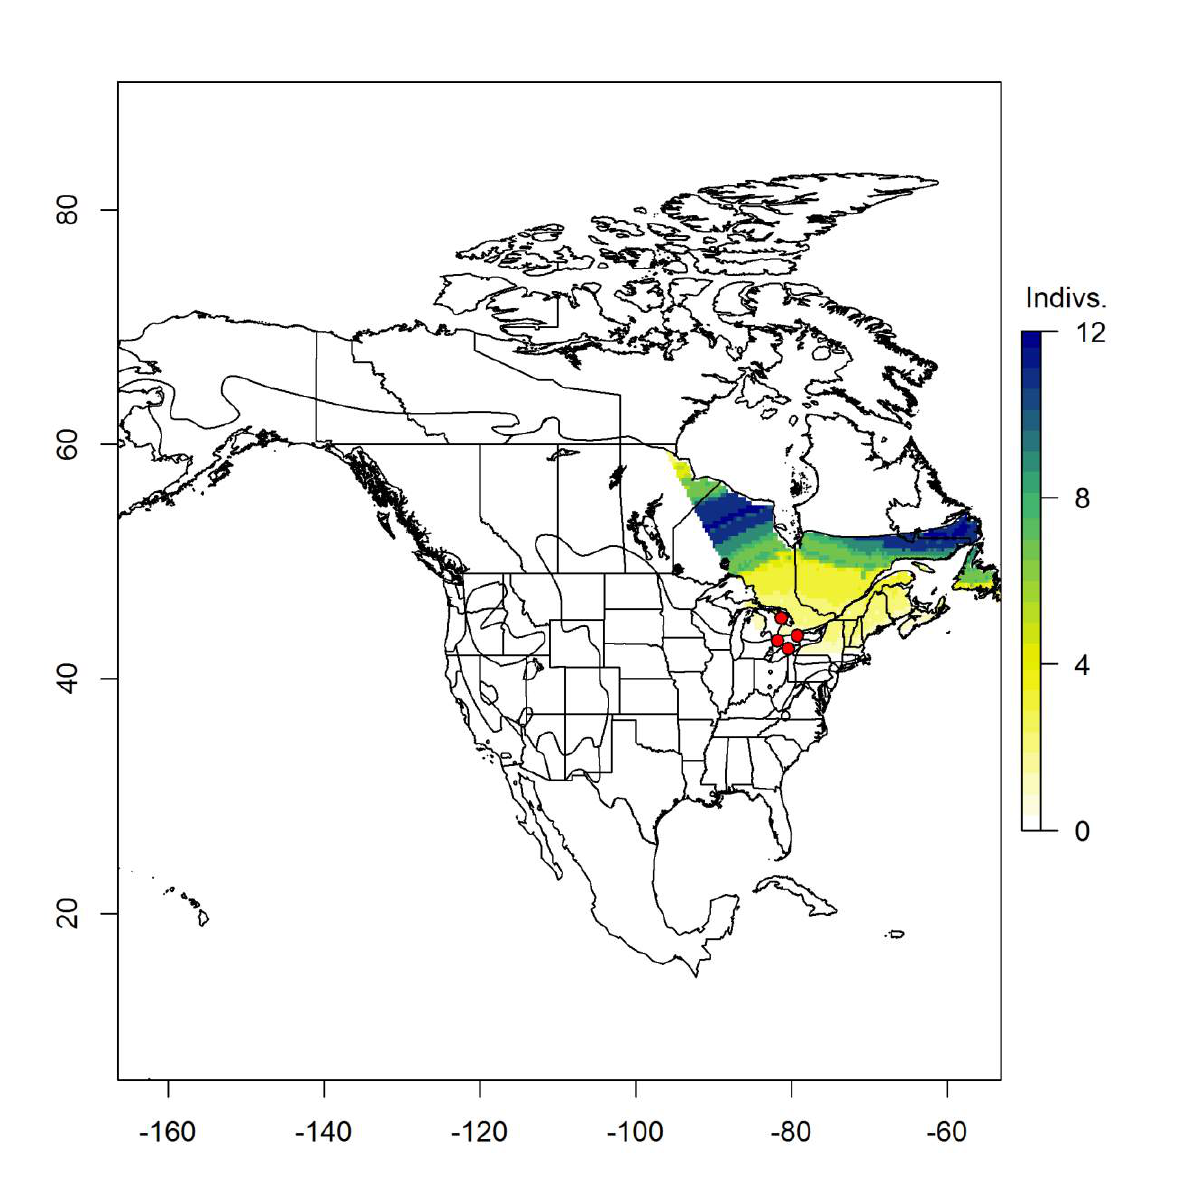
Figure A2.4: Probable origins of Hermit Thrushes ( Catharus guttatus ) captured during spring migration at CMMN stations in Southwest Ontario (AuBO (n=1), BPBO (n=3), LPBO (n=8), TTPBRS